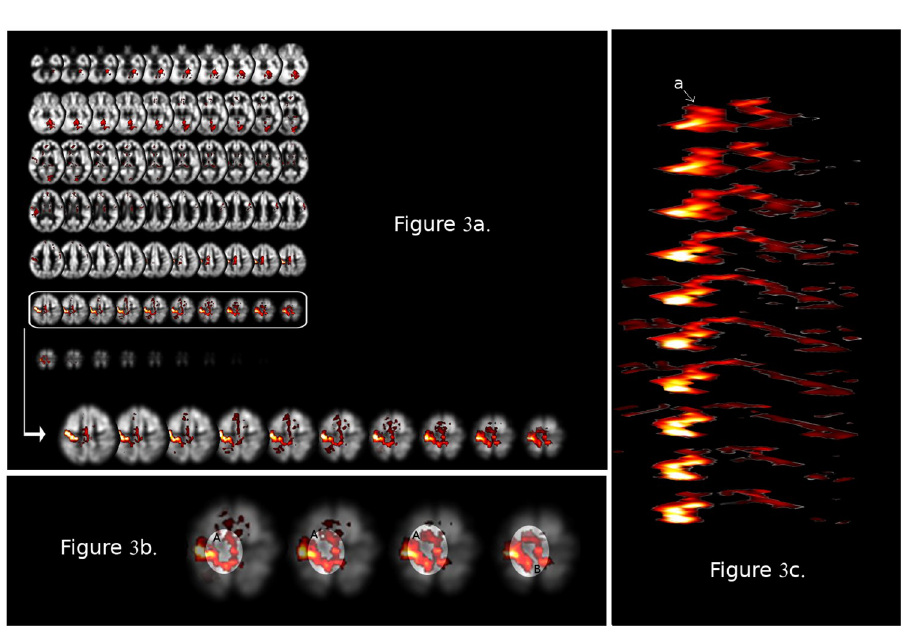
Fig 3. (a) The activation map is adapted from a recent study [63] of the functional organization of motor responses during an inter-hemispheric transfer tasks. The activation map shows activation in contra-lateral motor cortex (for right handed responses). Responses in left primary motor cortex (narrowly defined) are in the inset. Given that this is an activation map, the three-dimensional representation collapses across the dimension of time. The color scale is a statistical representation of signal amplitude. A loop in the lateral and medial aspects of Brodmann Areas 4 and 6 (M1 and Supplementary Motor Area, respectively) suggest a complex topological structure in three-dimensional space the characteristics of which may reflect a hidden structure-function relationship. Notably, activation-based analyses lack the ability to quantify structure in the way that TDA can. This illustrative example can be scaled up to consider the added dimension of time, as TDA approaches can viably identify structure in higher dimensional spaces where the temporal dimension is retained. (b). The four dorsal-most frames from the inset in (a) are shown. As seen, there is a “ring-like” shape within the activated regions. (c) The activated clusters from the cross sections in (a) are extracted from the template, and are stacked in three-dimensional space to form a three-dimensional geometric figure.